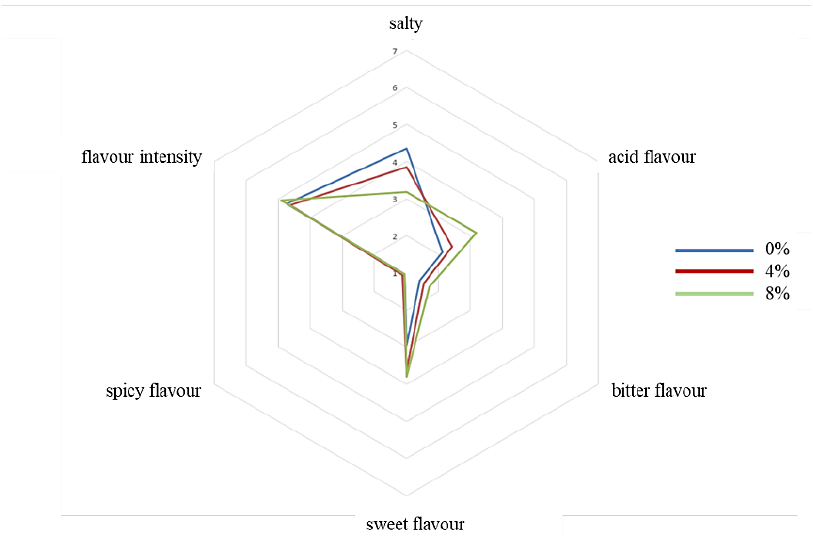
Figure 2. Sensory descriptive analysis. Basic tastes. (0%, control; 4%, burgers added with 4% apple